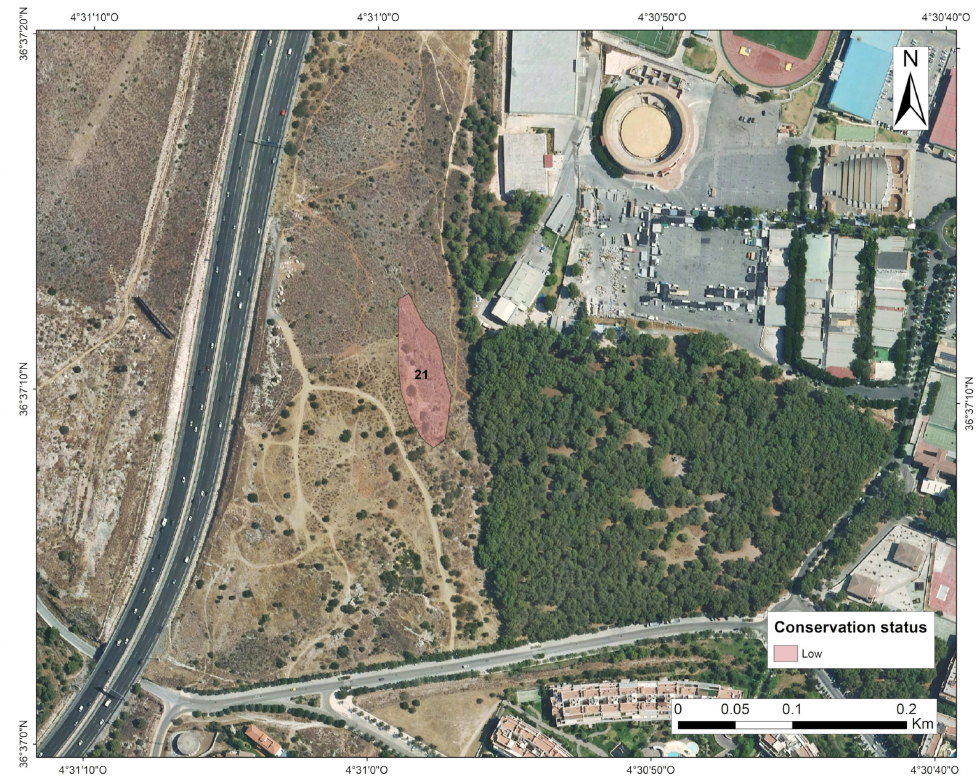
Figure 5. Torremolinos locality cartography. The color indicates the DC of the 5220* HCI at each polygon number: the red color corresponds with a reduced degree of conservation (DC). The enu- meration of the polygons follows Table 2. The base map used is the World Imagery, provided by ESRI [52]: layer services credits source: Esri, Maxar, GeoEye, Earthstar Geographics, CNES/Airbus DS, USDA, USGS, AeroGRID, IGN, and the GIS User